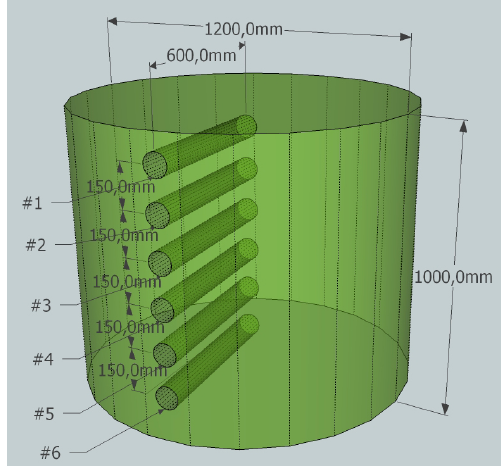
Figure 5. Silage bale dimensions and sample